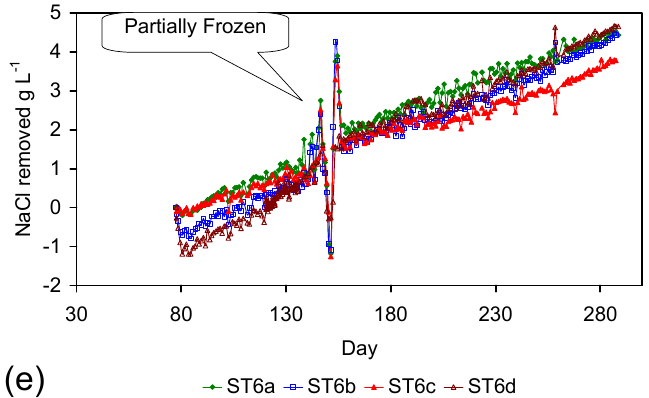
Figure C10. ( a ) pH vs. Eh; ( b ) EC vs. day; ( c ) pH vs. day; ( d ) Eh vs. day; ( e ) NaCl Removed (calculated from EC and residual water volume) vs. day. ZVM TP = copper sheathed pellets (15 mm OD) placed in water at a concentration of ST6a = 15.7 g·L − 1 ; ST6b = 15.1 g·L − 1 ;